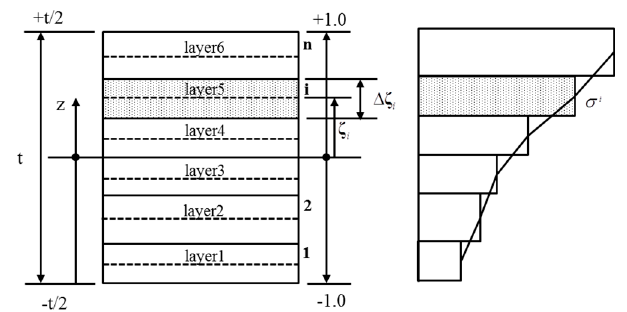
Figure 3. Layered shell model and stress distribution diagram .